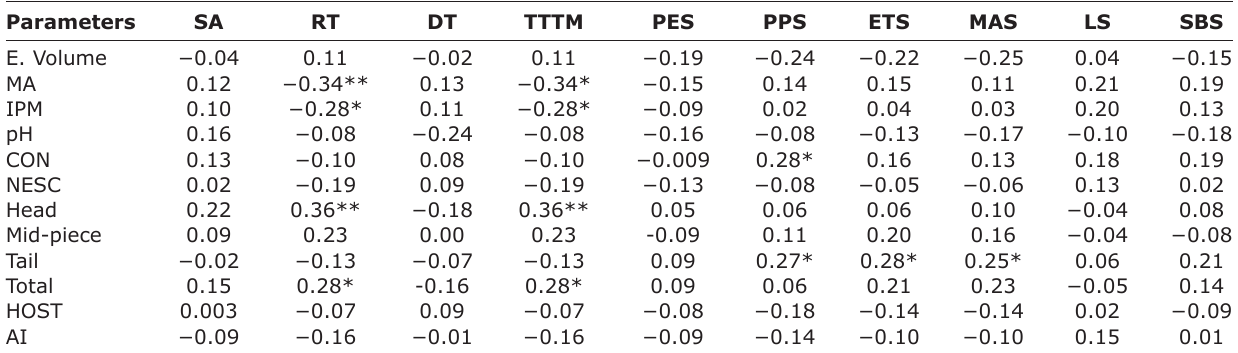
Table-3: Correlation matrix showing coefficients of correlation between seminal attributes and sexual behavior parameters of adult Sahiwal bulls.